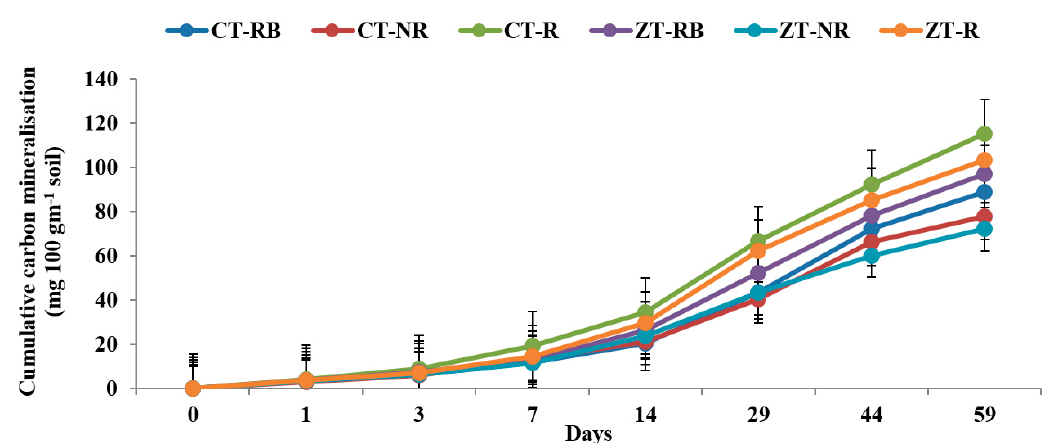
Figure 5. Cumulative carbon mineralization (mg 100 g − 1 soil) from micro-aggregate in 0–5 cm depths as affected by 18 years of tillage and residue management in a rice–wheat cropping system in an Inceptisol at 37 °C. ZT = zero tillage; CT = conventional tillage; NR = no residue; RB = residue burning; R = residue retention. Error bars identify LSD ( p ≤ 0.05) of different treatments.